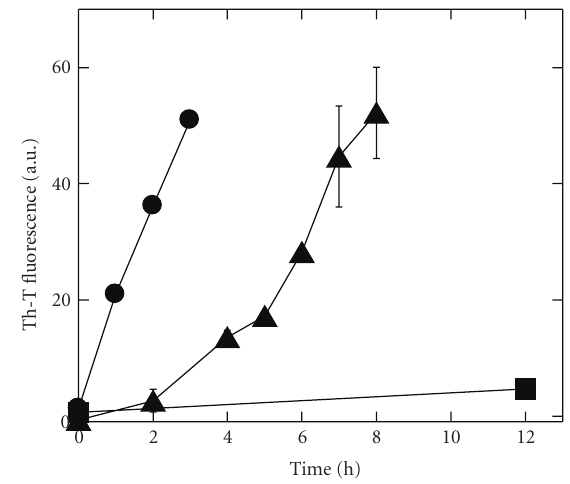
Figure 1: A β aggregation in the presence of raft-like liposomes. A β s (5 μ M or 50 μ M) were incubated with GM1/cholesterol/SM (1:1:1) small unilamellar vesicles at a GM1-to-A β ratio of 5 at 37 ◦ C without agitation, and the aggregation was monitored by the Th-T assay. Symbols: circles, 5 μ M A β -(1–42); squares, 5 μ M A β -(1– 40); triangles, 50 μ M A β -(1–40). Data taken from